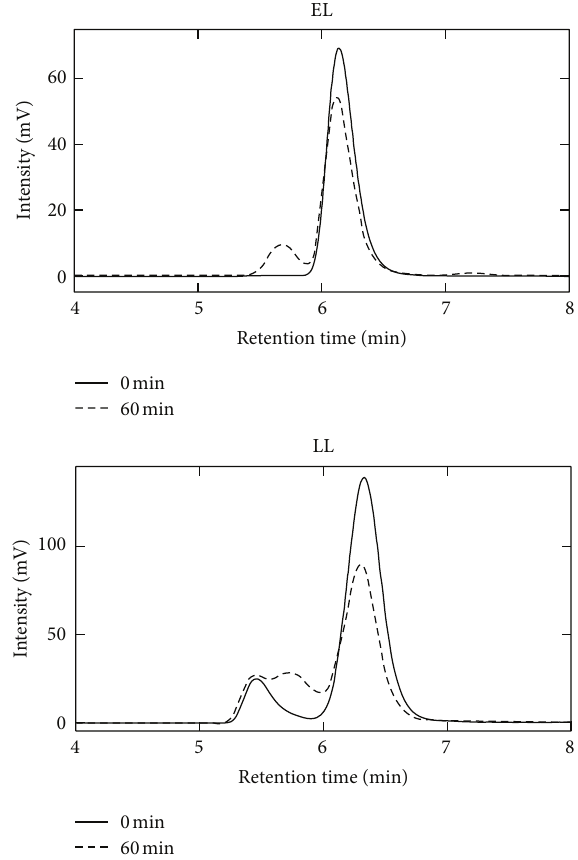
Figure 5: HPLC chromatograms of EL and LL in O/W emulsion before and after 60-minute light